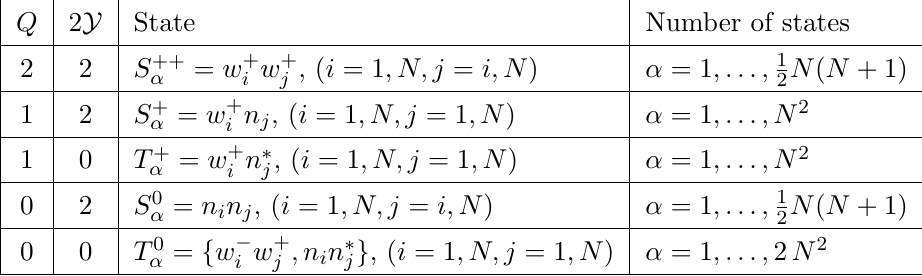
Table 3 . List of two body scalar states separated by ( Q; Y